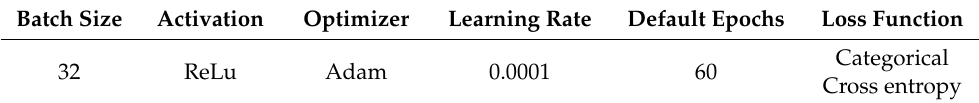
Table 2. Deep learning model hyperparameters used in the experiments in this study.